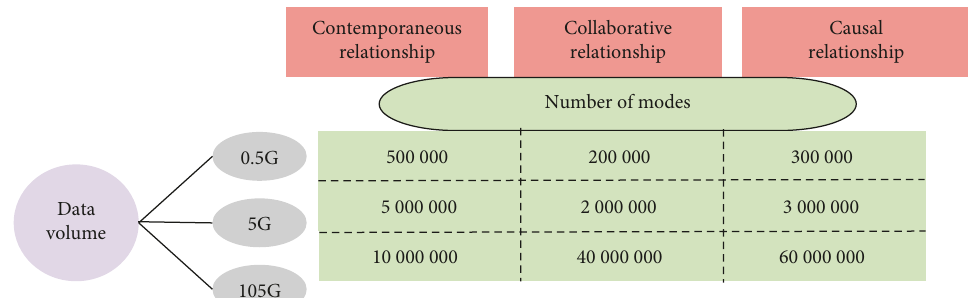
Figure 4: Simulation dataset